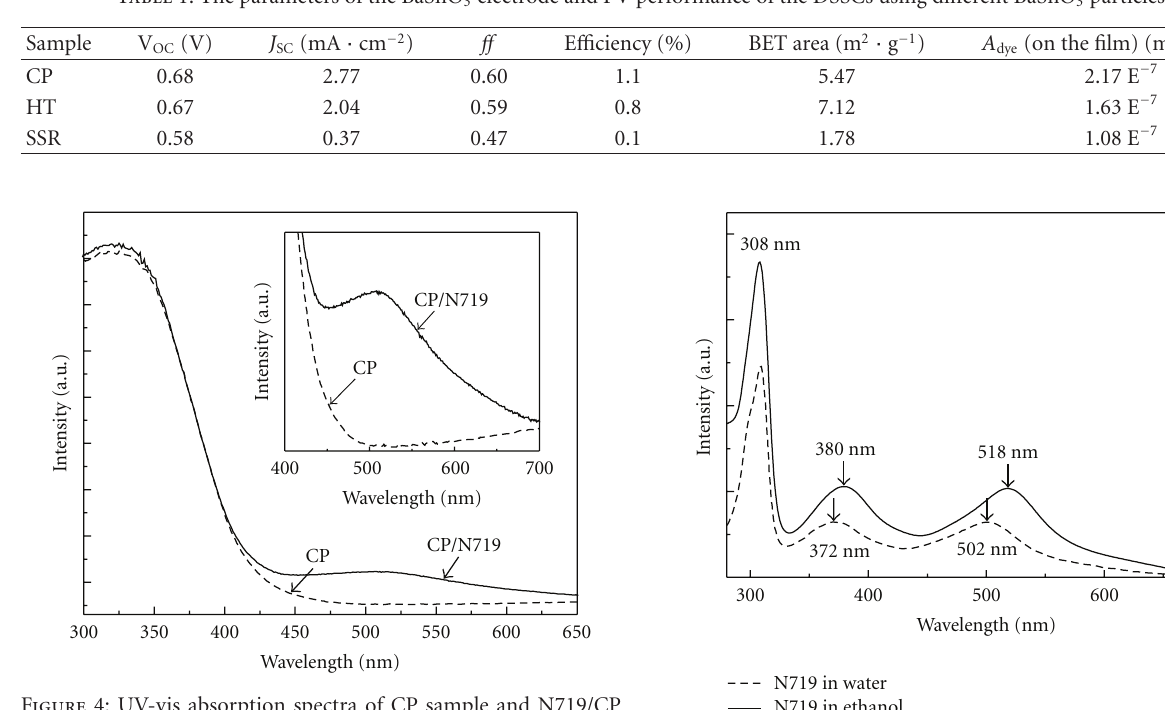
Figure 4: UV-vis absorption spectra of CP sample and N719/CP composites.